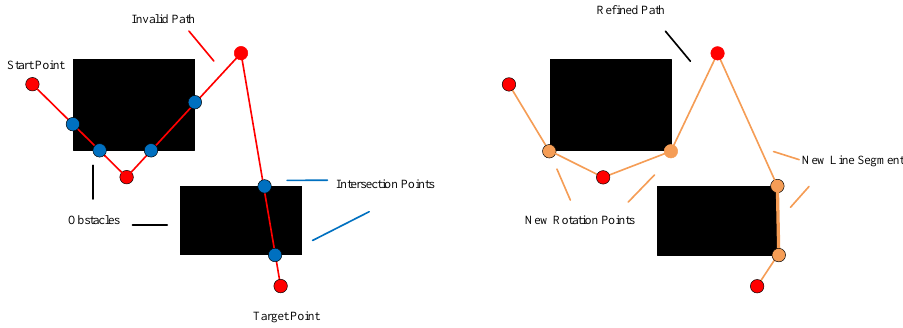
Figure 3. The invalid solution operator is presented. In the sub-figure on the left, the blue circles represent the intersection points of the path and the obstacle. The right sub-figure shows the new path generated by the Dijkstra algorithm.